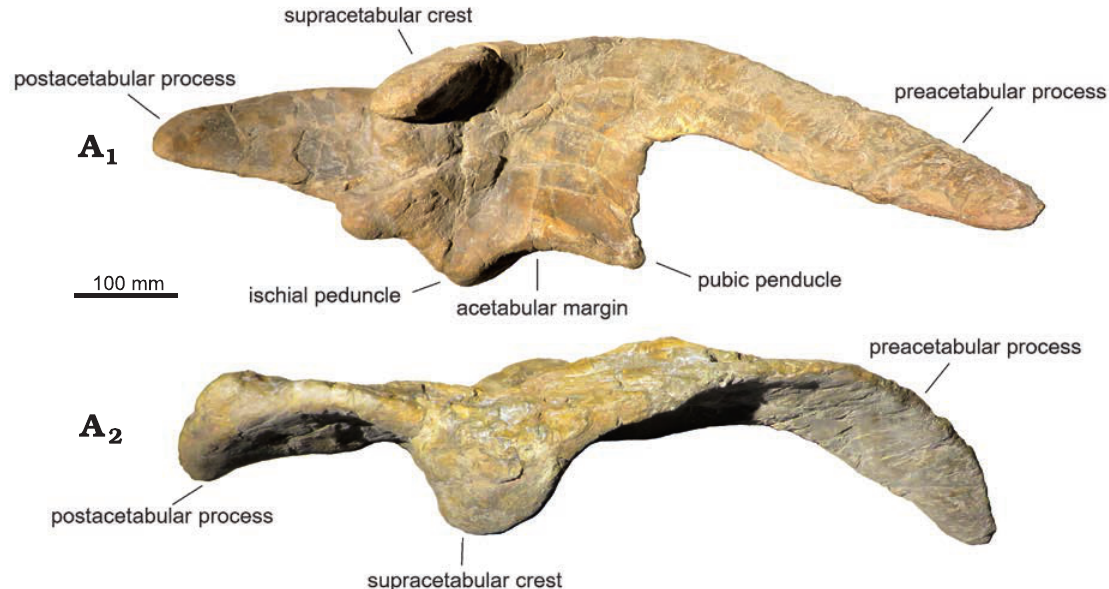
Fig. 8. Ilium of hadrosaurid dinosaur Velafrons coahuilensis Gates, Sampson, Delgado de Jesús, Zanno, Eberth, Hernandez-Rivera, Aguillón-Martínez, and Kirkland, 2007 (CPC 59) from Rincón Colorado, Coahuila, Mexico, upper Campanian; in lateral (A 1 ) and dorsal (A 2